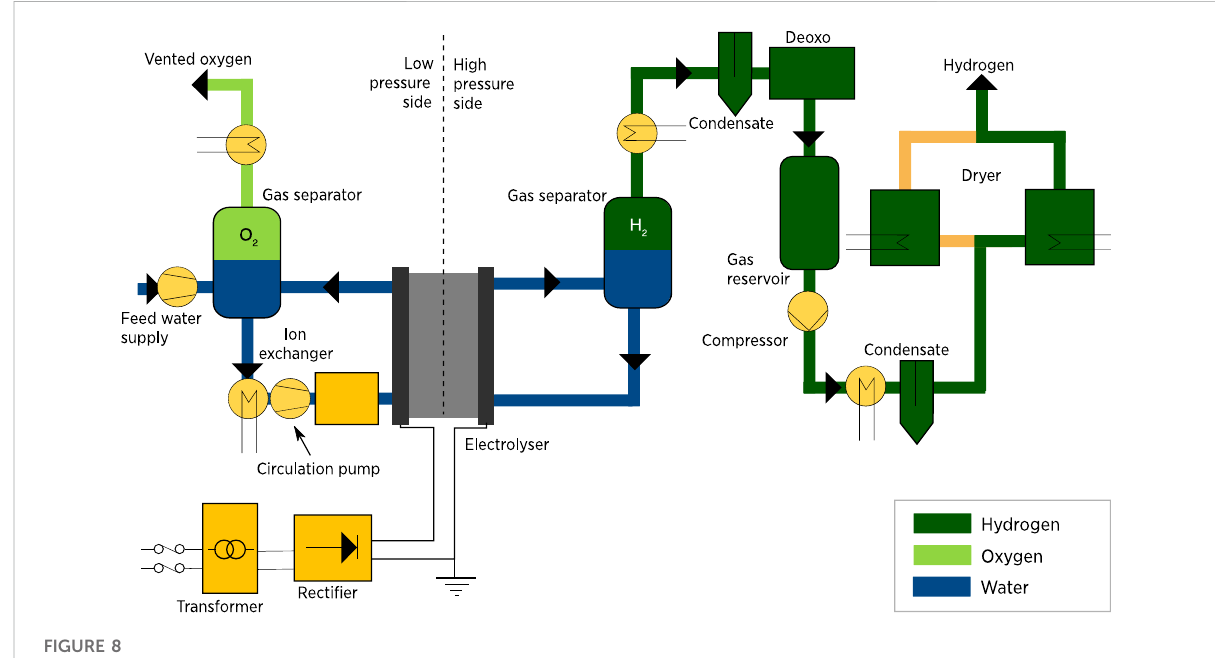
FIGURE 8 PEM electrolyser system. Source (IRENA, 2020).